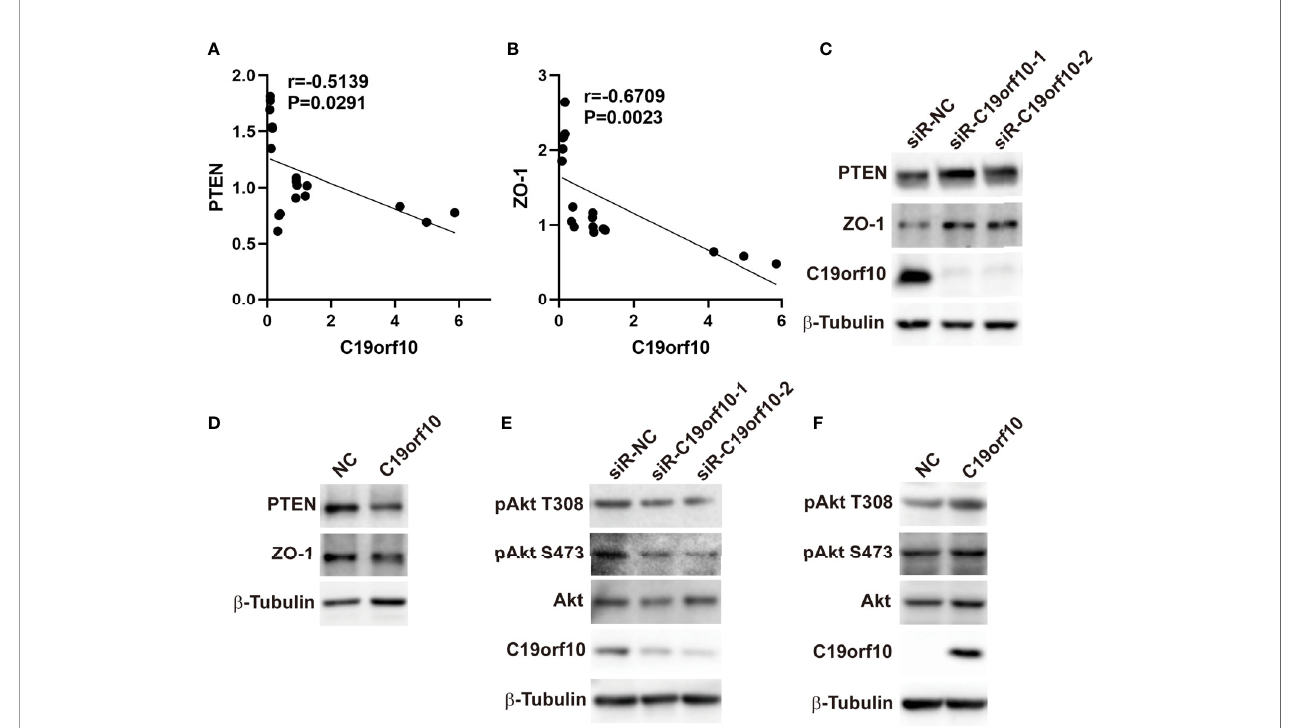
FIGURE 6 | C19orf10 promotes KIRC progression via ZO-1 and PTEN/Akt pathway. (A) ZO-1 was the C19orf10 negatively regulated genes. (Pearson correlation analysis, n=18). (B) PTEN was negatively correlated with C19orf10. (Pearson correlation analysis, n=18). (C) Knockdown of C19orf10 increased PTEN and ZO-1 expression in ACHN cells. (D) Overexpression of C19orf10 decreased PTEN and ZO-1 expression in 769-P cells. (E) Knockdown of C19orf10 inhibited the phosphorylation of Akt. (F) Overexpression of C19orf10 activated